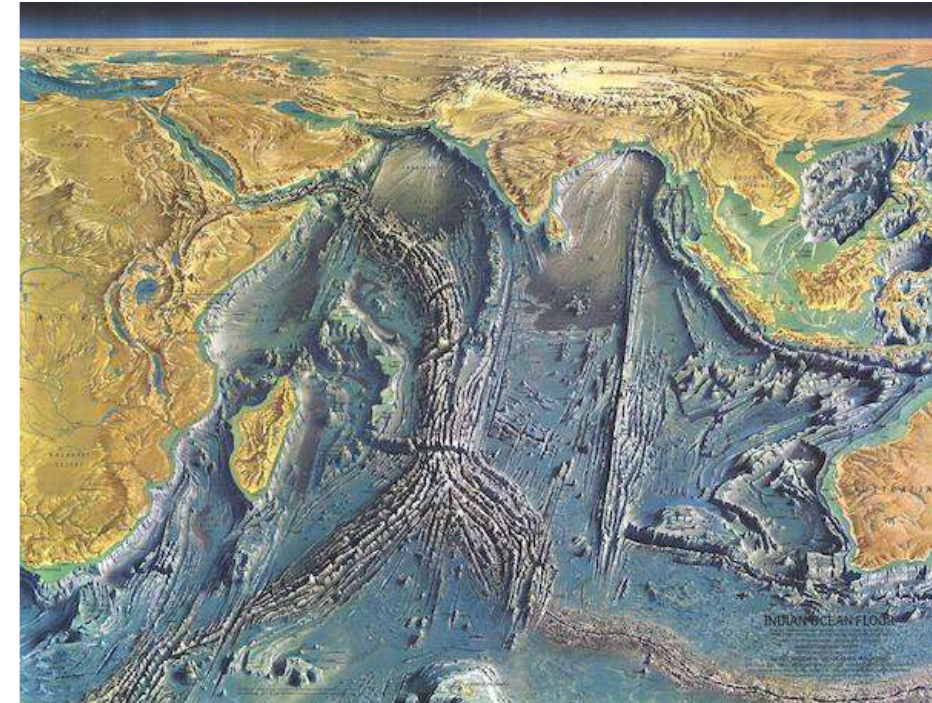
Figure 1. The Indian Ocean floor, by NatGeo dated 1967